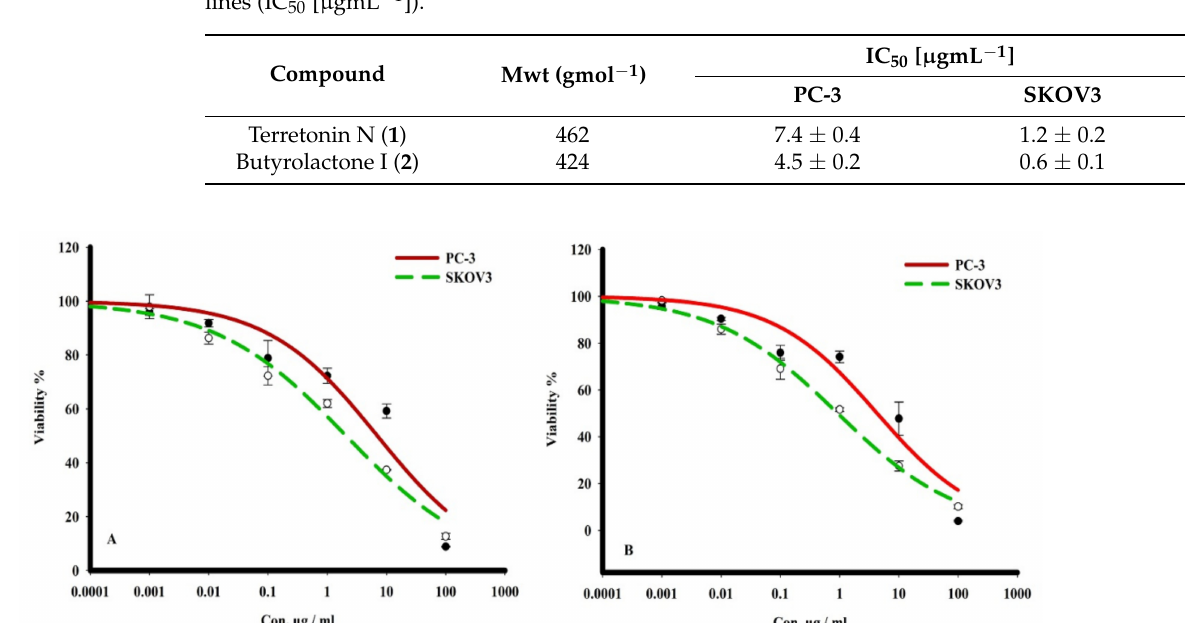
Table 1. In vitro cytotoxicity of terretonin N ( 1 ) and butyrolactone I ( 2 ) against PC-3 and SKOV3 cell